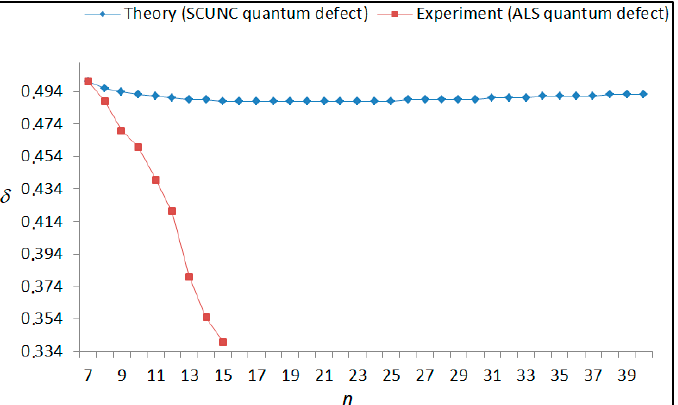
Figure 15. Variations of the quantum defect ( δ ) with the principal quantum number n for the 4 s 2 4 p 2 ( 1 D 2 ) ns Rydberg series originating from the 2 P ° 1/2 metastable state of Se + converging to the 1 D 2 series limits in Se 2+ .